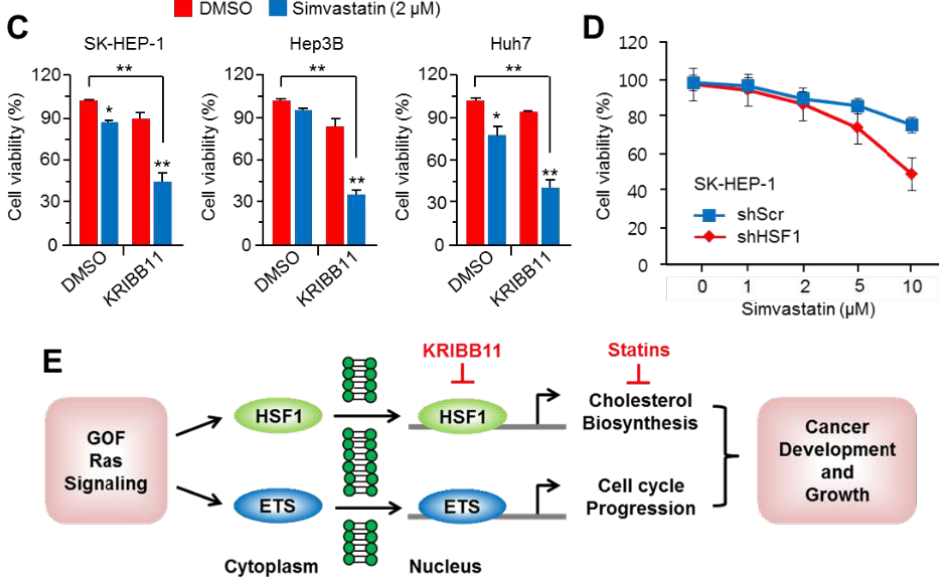
Figure 6. HSF1 inhibition sensitized the suppression of HCC cell growth in cholesterol-depleted conditions. ( A ) SK-HEP-1, Hep3B, and Huh7 were incubated for 24 h in normal FBS or DL-FBS in the absence or presence of KRIBB11 (5 µ M), and then cells were used to measure intracellular cholesterol levels. The values represent the mean ± SD of three independent experiments performed in duplicate. ( B ) SK-HEP-1, Hep3B, and Huh7 were incubated for 48 h in normal FBS or DL-FBS in the absence or presence of various concentrations of KRIBB11 (2, 5, and 10 µ M), as indicated. Cell viability was measured by crystal violet staining. The values represent the mean ± SD from three independent experiments performed in duplicate. ( C ) SK-HEP-1, Hep3B, and Huh7 were incubated for 48 h in Dimethyl sulfoxide (DMSO) (as a control) or simvastatin (2 µ M) in the absence or presence of KRIBB11 (5 µ M). The values represent the mean ± SD from three independent experiments performed in duplicate. ( D ) HSF1 knocked-down SK-HEP-1 cells were incubated with various concentrations of simvastatin (1, 2, 5, and 10 µ M) for 48 h, as indicated. The values represent the mean ± SD from three independent experiments performed in duplicate. ( E ) Proposed molecular mechanism by which HSF1 and erythroblast transformation-specific (ETS) transcription factor activated by gain-of-function (GOF) RAS-MAPK signaling promotes cholesterol biosynthesis and cell cycle progression, and this regulatory axis may be involved in cancer development and progression. * p < 0.05; ** p < 0.01; ns, not significant.